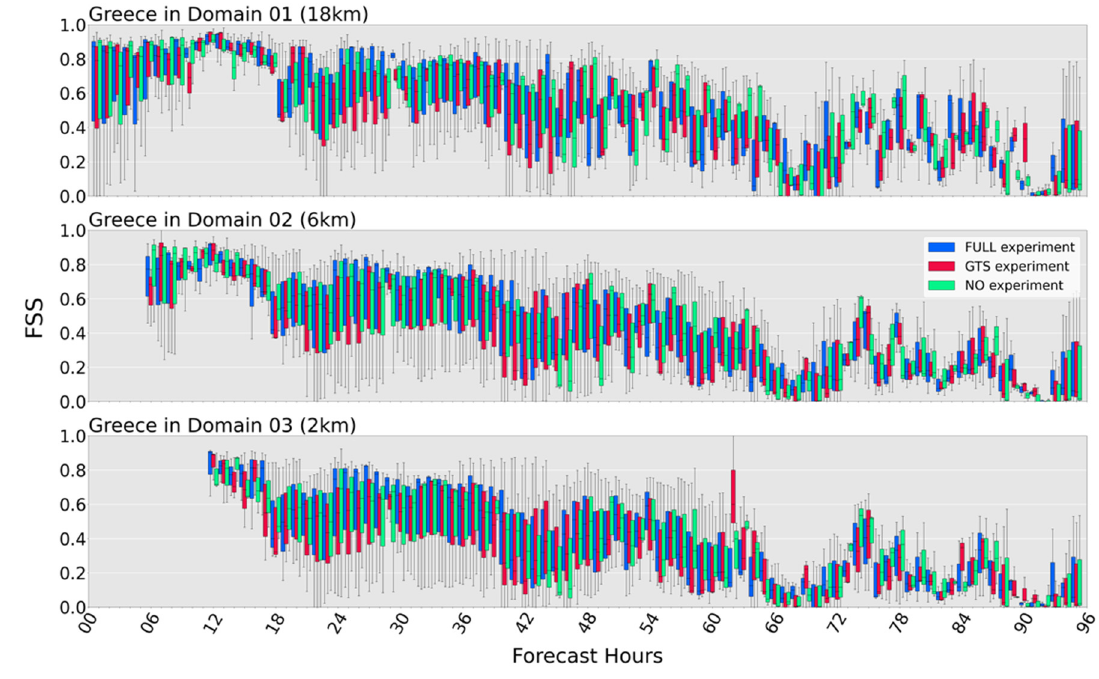
Figure 10. Hourly time series of precipitation accumulation FSS for the area of Greece. Each panel refers to a specific spatial resolution domain and the scores achieved for each type of experiment (i.e., FULL, GTS, NO). In blue are the boxplots for the FULL experiment, the GTS experiment is depicted in red, and the NO experiment is depicted in green.